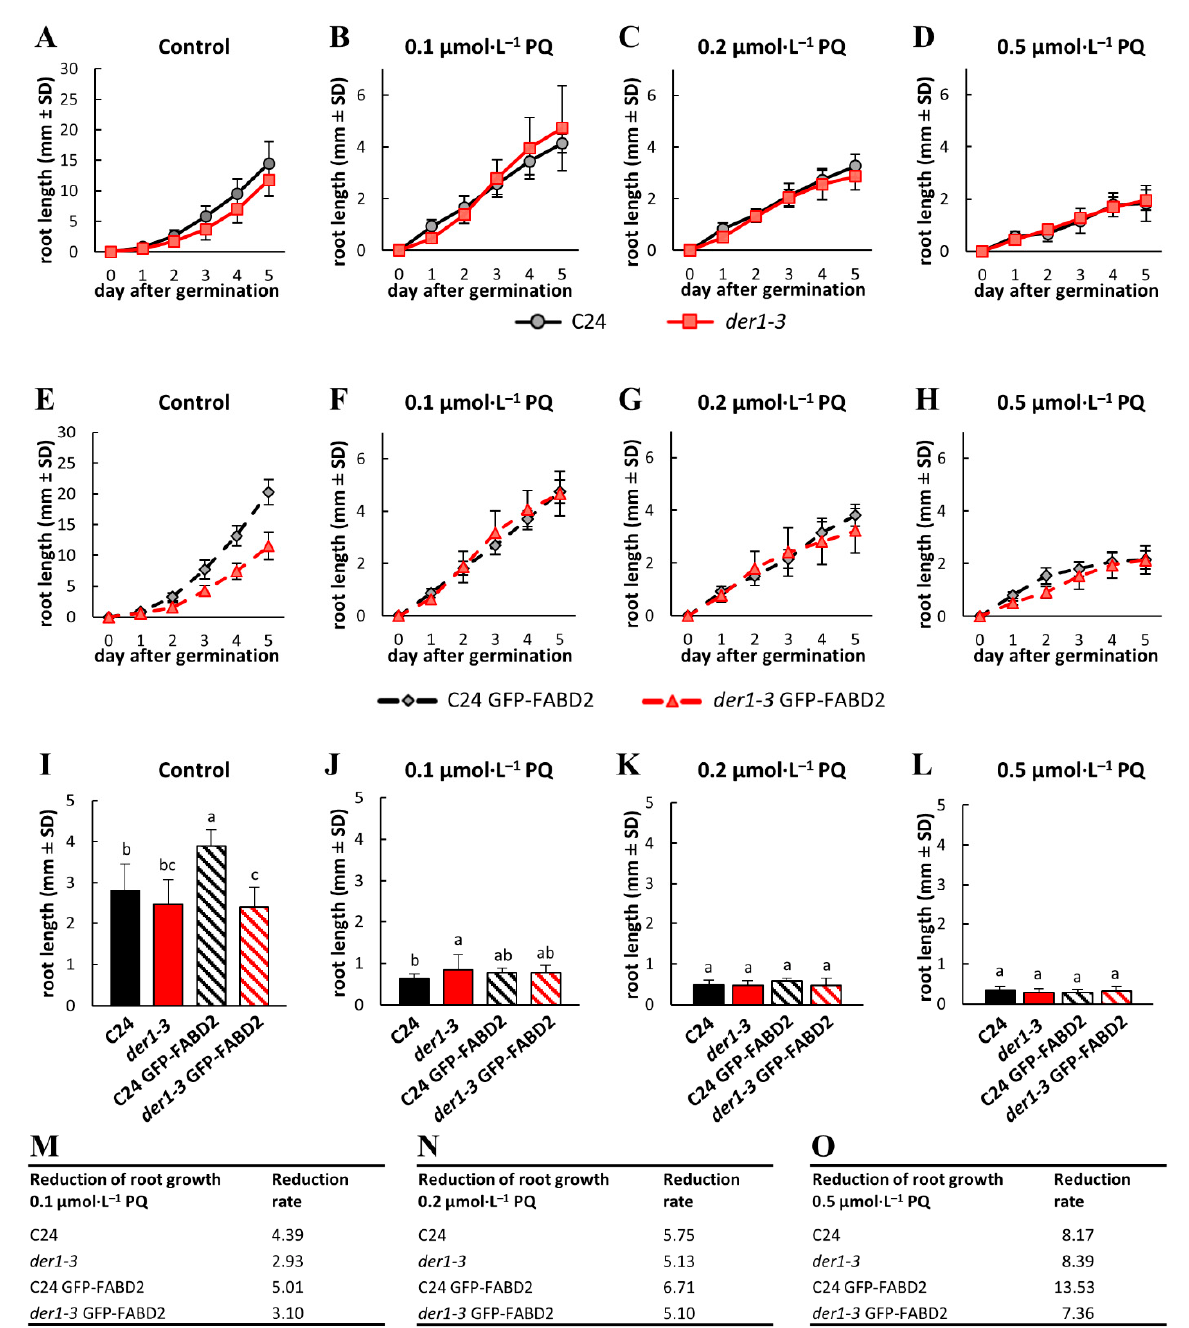
Figure 2. Root growth rate in plants of the control C24, der1–3 mutant and transgenic C24 and der1–3 lines expressing pro35S::GFP:FABD2 after germination in paraquat (PQ)-containing media. ( A – D ) Root growth rate within the first 5 days after germination of the control C24 and der1–3 mutant plants on the control media ( A ) and on media containing 0.1 ( B ), 0.2 ( C ) and 0.5 ( D ) µmol·L − 1 of PQ. ( E – H ) Root growth rate within the first 5 days after germination of the transgenic C24 line carrying GFP-FABD2 and transgenic der1–3 line carrying GFP-FABD2 on the control media ( E ) and on media containing 0.1 ( F ), 0.2 ( G ) and 0.5 ( H ) µmol·L − 1 of PQ. ( I – L ) Average root growth per 24 h on the control media ( I ) and on media containing 0.1 ( J ), 0.2 ( K ) and 0.5 ( L ) µmol·L − 1 of PQ. ( M – O ) Reduction ratio (fold change in respect to control) of average root growth in respective lines on media containing 0.1 ( M ), 0.2 ( N ) and 0.5 ( O ) µmol·L − 1 of PQ. Experiments were repeated two times with 16 plants per line (control) and 12 plants per line (PQ). Different lowercase letters above the bars ( I – L ) represent statistical significance according to one-way ANOVA and subsequent LSD test at p value < 0.05.